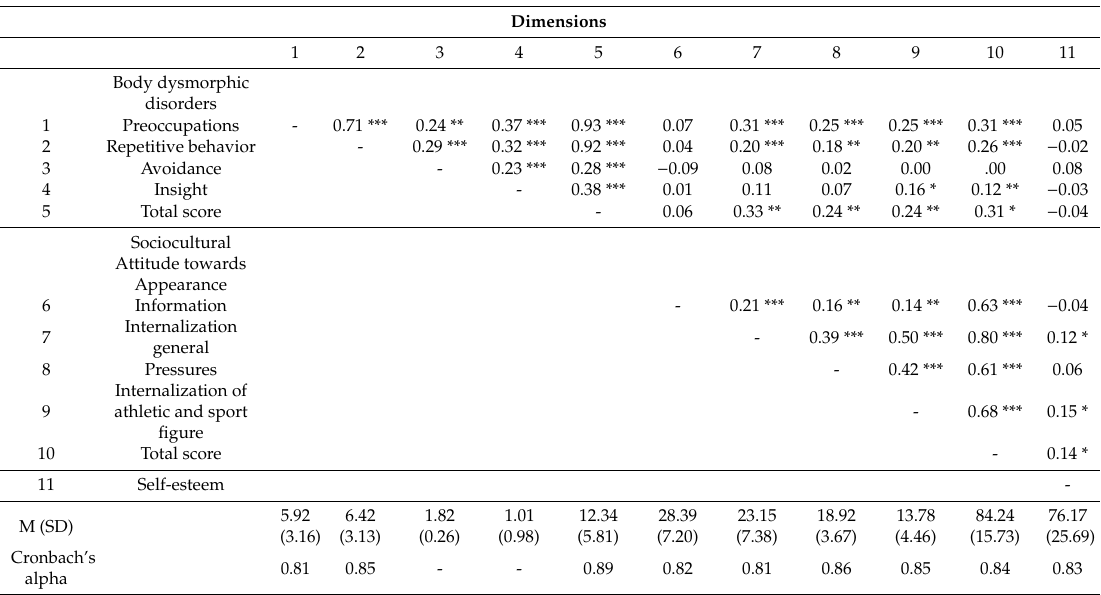
Table 1. Overview of correlation coe ffi cients between body dysmorphic disorders (experts’ ratings), sociocultural attitude towards appearance, and self-esteem.